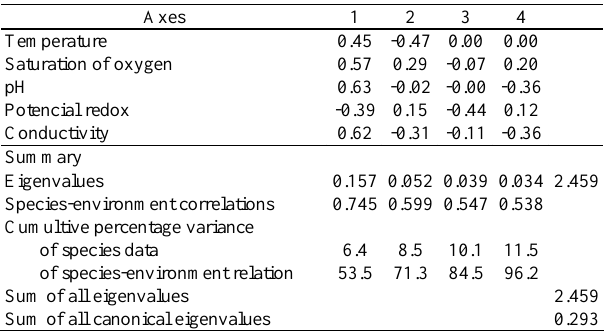
Table 5. Summary of Canonical Correspondence Analysis of data for biotic and abiotic factors in the Paraíba do Sul River - Funil Reservoir